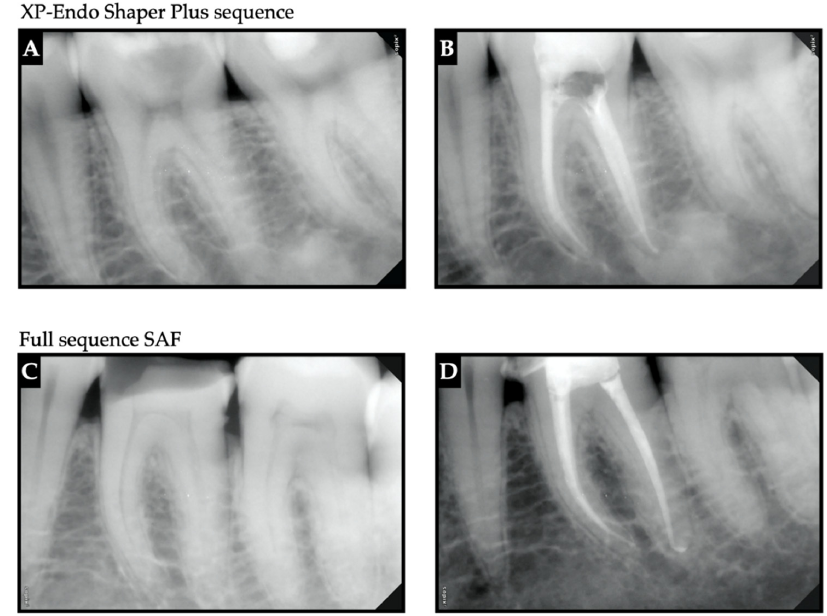
Figure 2. Representative radiovisiographs (RVGs) of pre-operative and post-obturation for XP-endo shaper plus sequence (mandibular second molar) ( A , B ) and full-sequence SAF (mandibular first molar) ( C , D ).